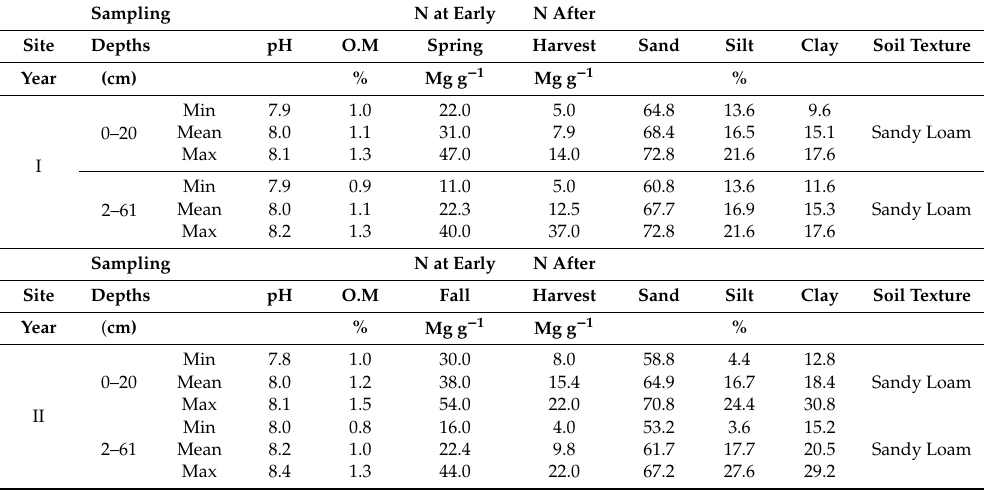
Table 1. Summary of the soil properties for the soil samples acquired at depths of 0–20 cm and 20–61 cm. Sampling N at Early N After Site Depths